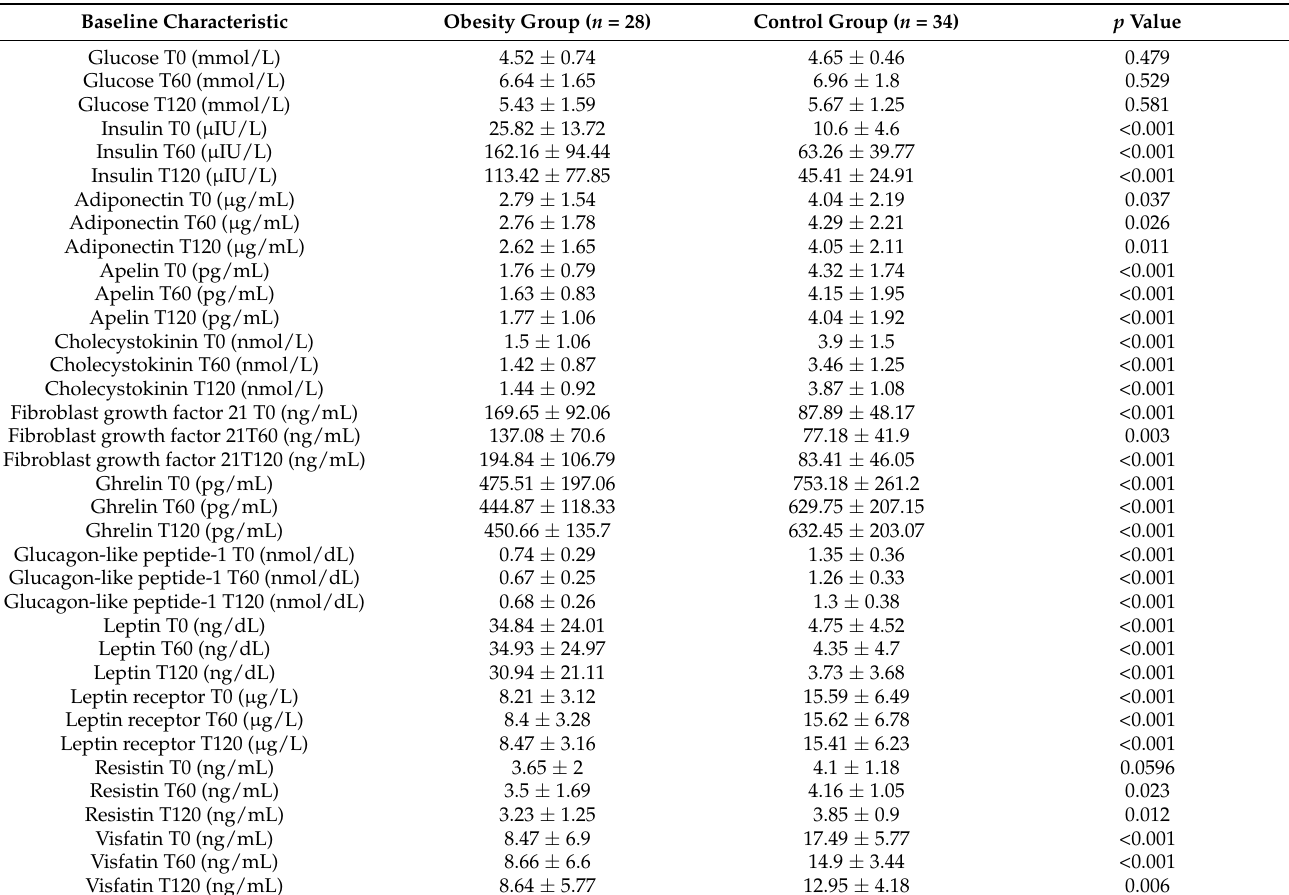
Table 2. The metabolic parameters of the study groups. Values are presented as mean ± standard deviation. Baseline Characteristic